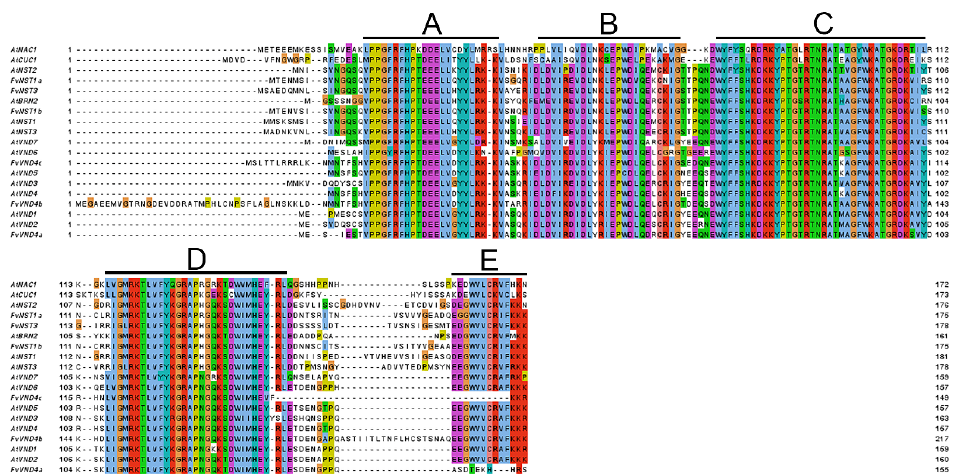
Figure 1. Amino acid sequences alignment of FvVNS and NAC proteins from Arabidopsis including AtVNSs ( A – E ). The proteins were initially aligned using Clustal omega. The NAC domain was marked with solid